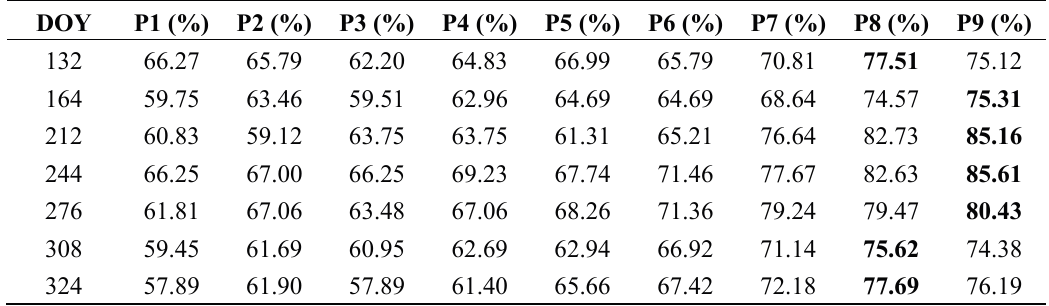
Table 4. Overall accuracies (DOY = Day-of-year, P1–P9 are the nine dynamic land cover classification processes P1–P9 described in Section